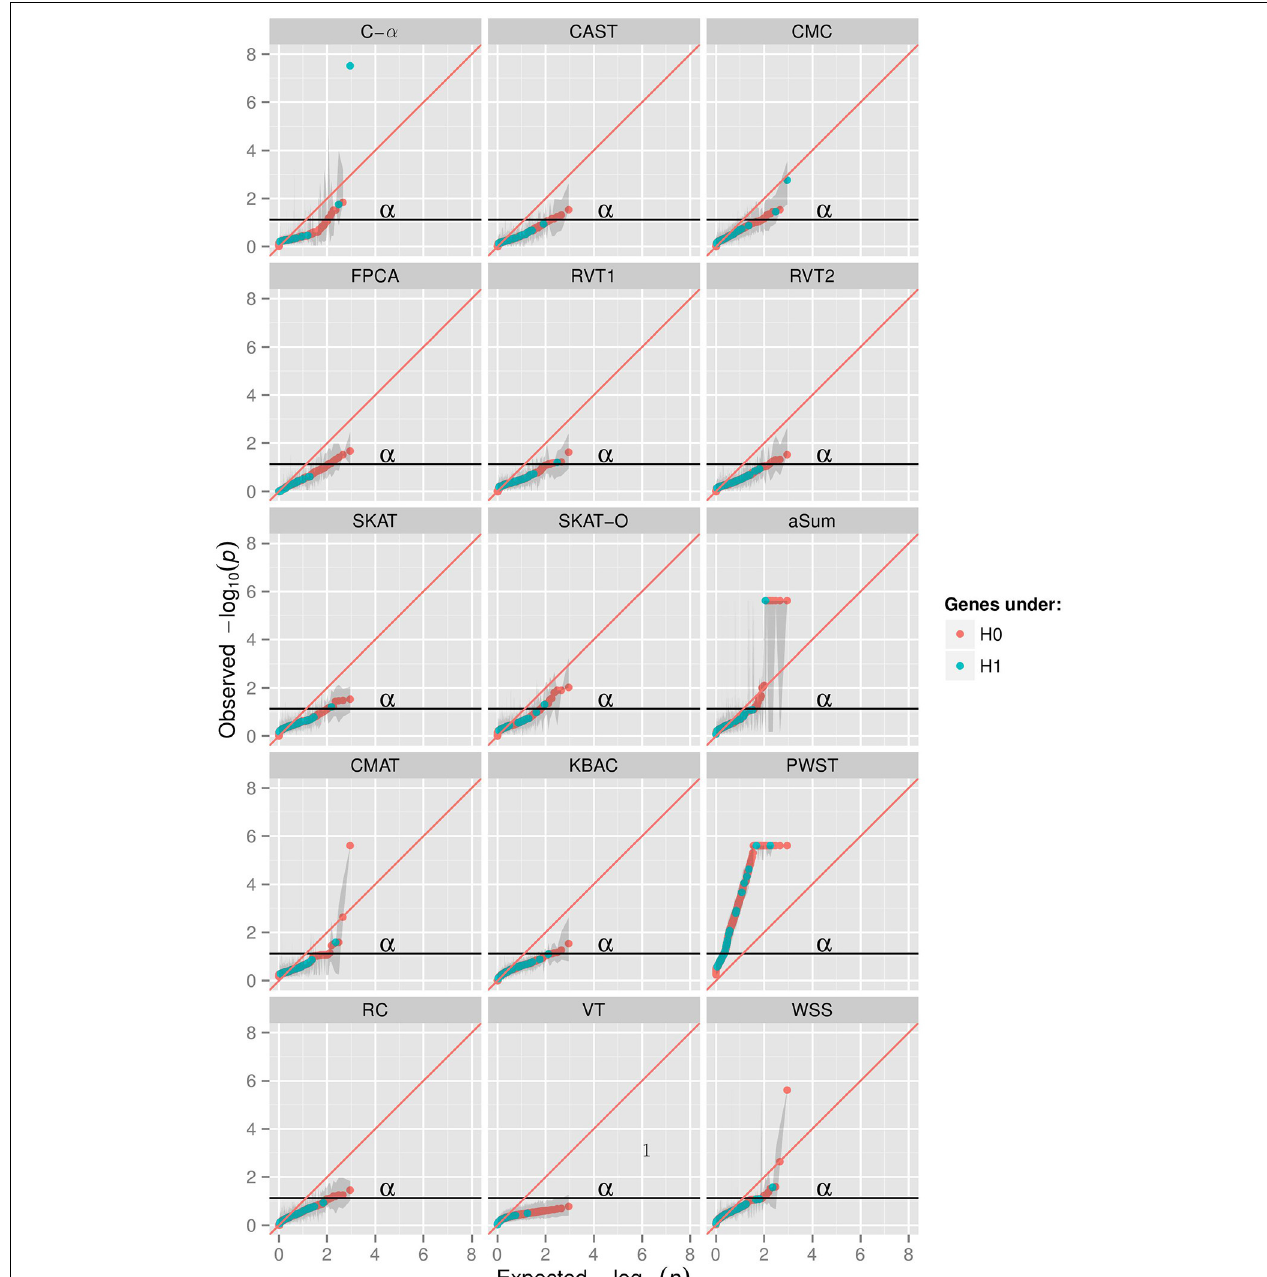
FIGURE 1 | Q-Q plots in 15 collapsing methods, minor allele frequency (MAF) threshold of 0 . 01, restriction to non-synonymuous variants, phenotype of affection status with no covariates; aSum, adaptive summation; CAST, cohort allelic sum test; CMAT, cumulative minor-allele test; CMC, combined multivariate cluster; FPCA, functional principal component analysis; KBAC, kernel-based adaptive cluster; PWST,